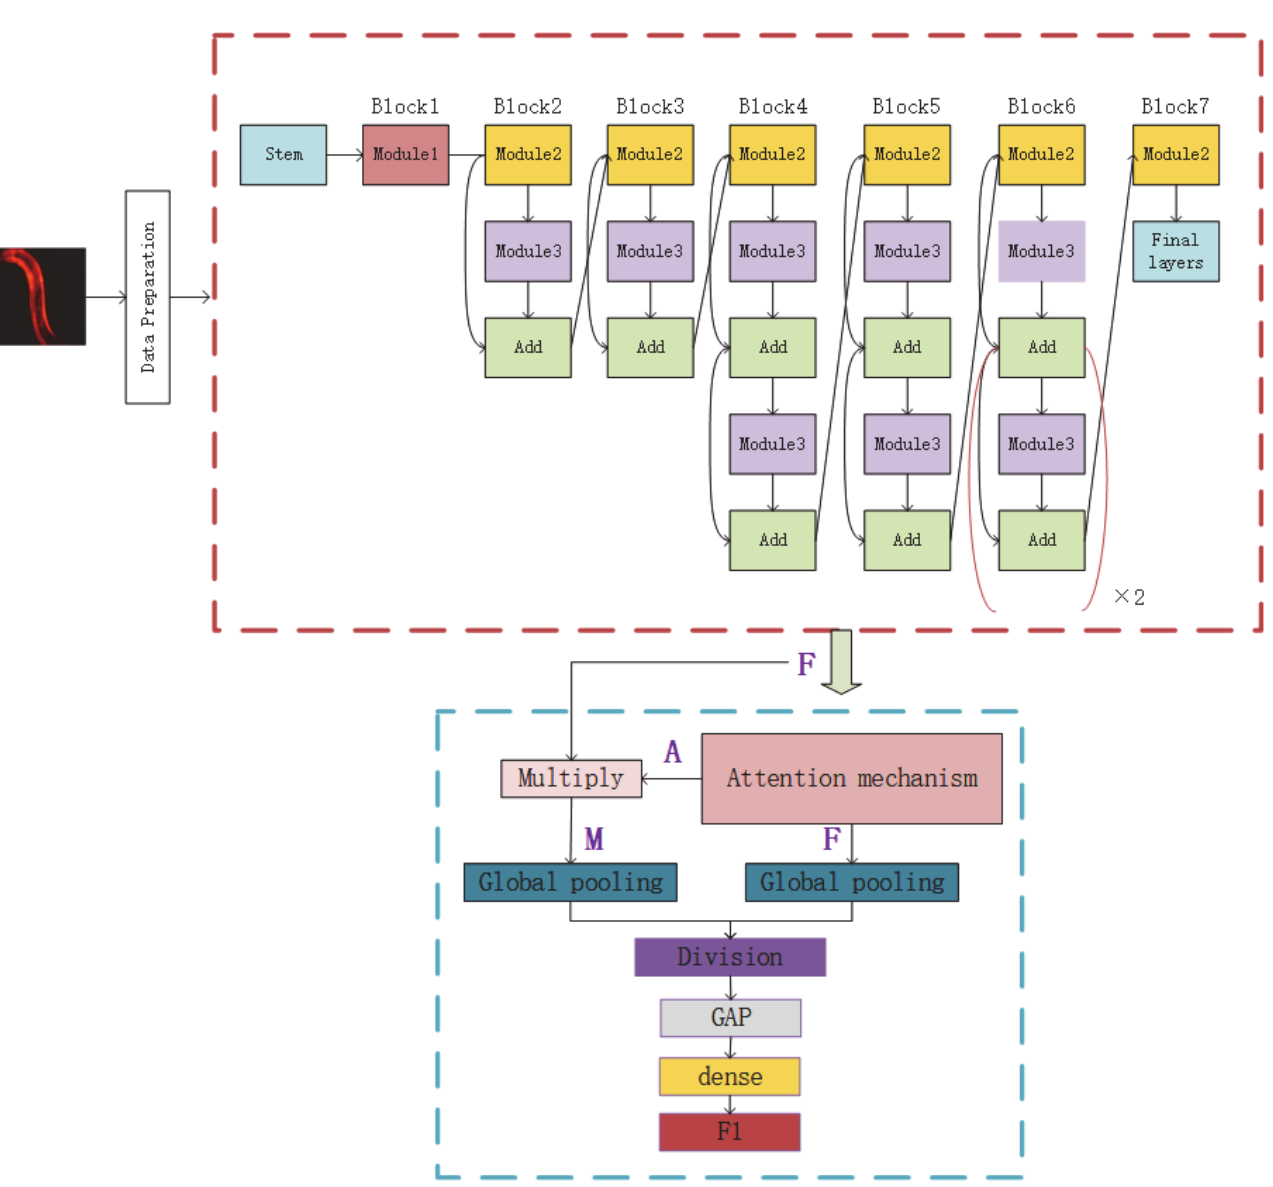
Figure 2. The EfficientNetB0 network is outlined by red dashed lines. Similar to the original EfficientNet model, Stem is a common structure. Module1 contains DepthwiseConv2D, BatchNormalization, and an activation function. Module2 consists of two module1 units which are connected by the Zero Padding layer in the middle. Module3 consists of a global pooling layer, rescaling, and two Conv2Ds. The attention module is outlined by blue dashed lines.